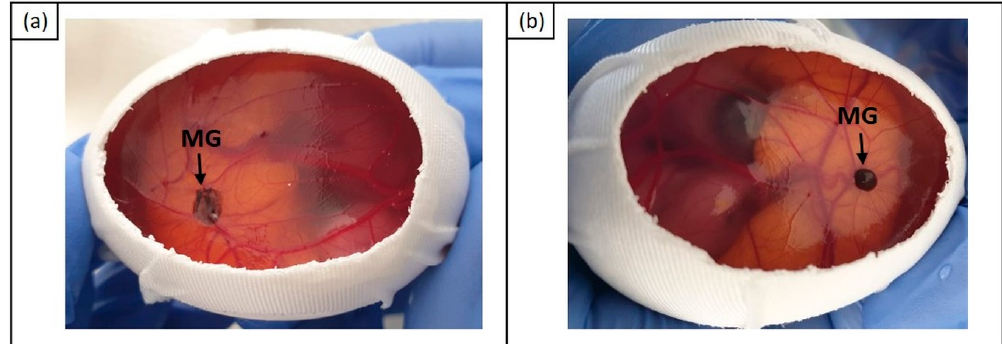
Figure 4. Images of chick embryo with Matrigel grafts at E16. ( a ) flat Matrigel graft; ( b ) 3D tumor organ. Abbreviation: MG = Matrigel graft.